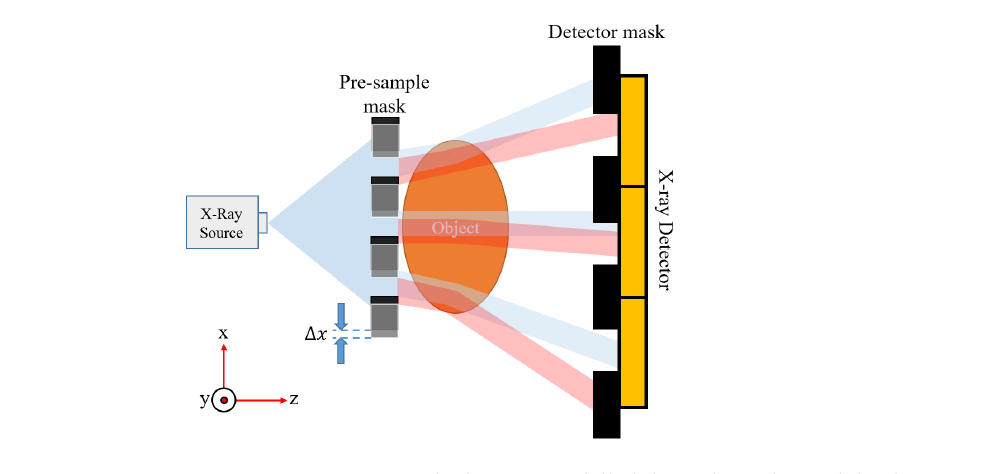
Figure 11. Environmental vibration modelled through mechanical displacement which causes mis- alignment between pre-sample and detector mask in an EI-XPCi system for high-resolution imag- ing application.